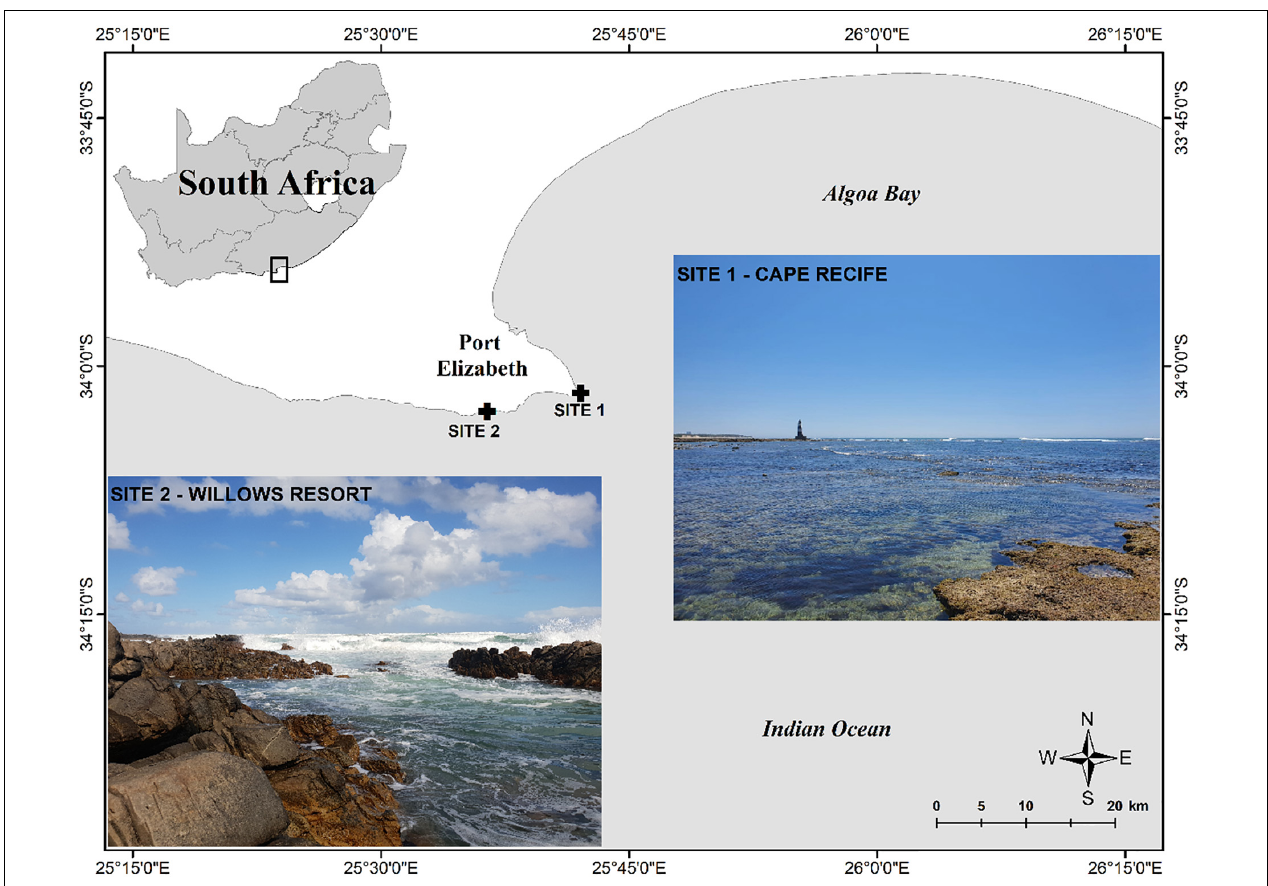
FIGURE 1 | Location of the two study sites along the south coast of South